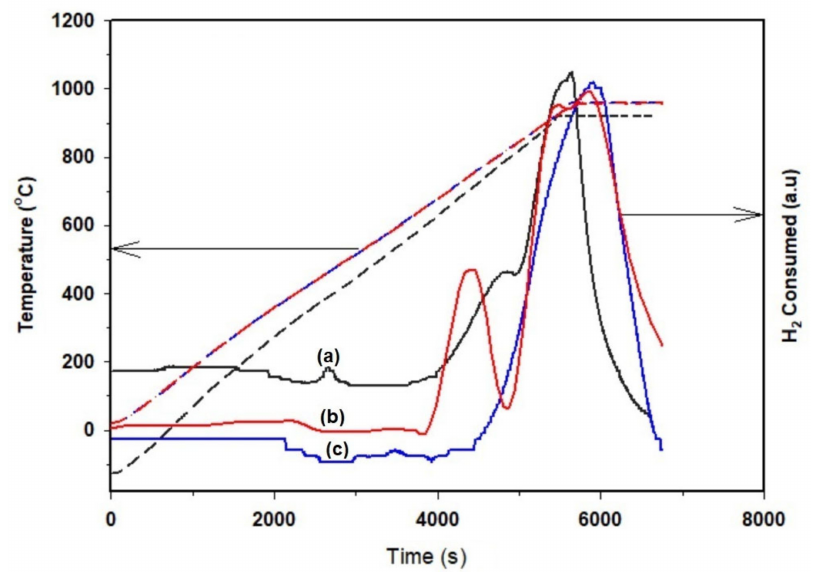
Figure 2. H 2 -TPR profiles of 5 wt.% (a) Ni 2 P/ ɣ -Al 2 O 3 , (b) CoP/ ɣ -Al 2 O 3 , and (c) Fe 2 P/ ɣ -Al 2 O 3 supported catalysts.